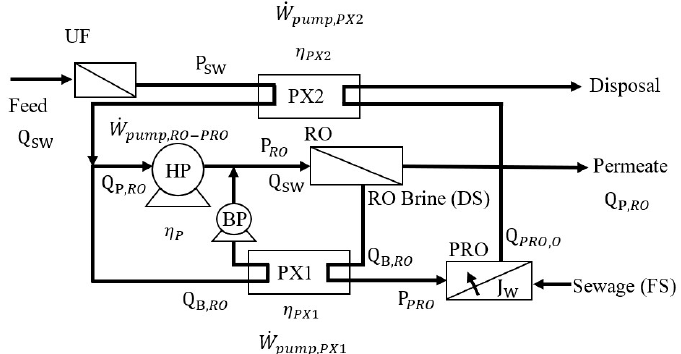
Figure 3. Schematic of the hybrid RO-PRO process.